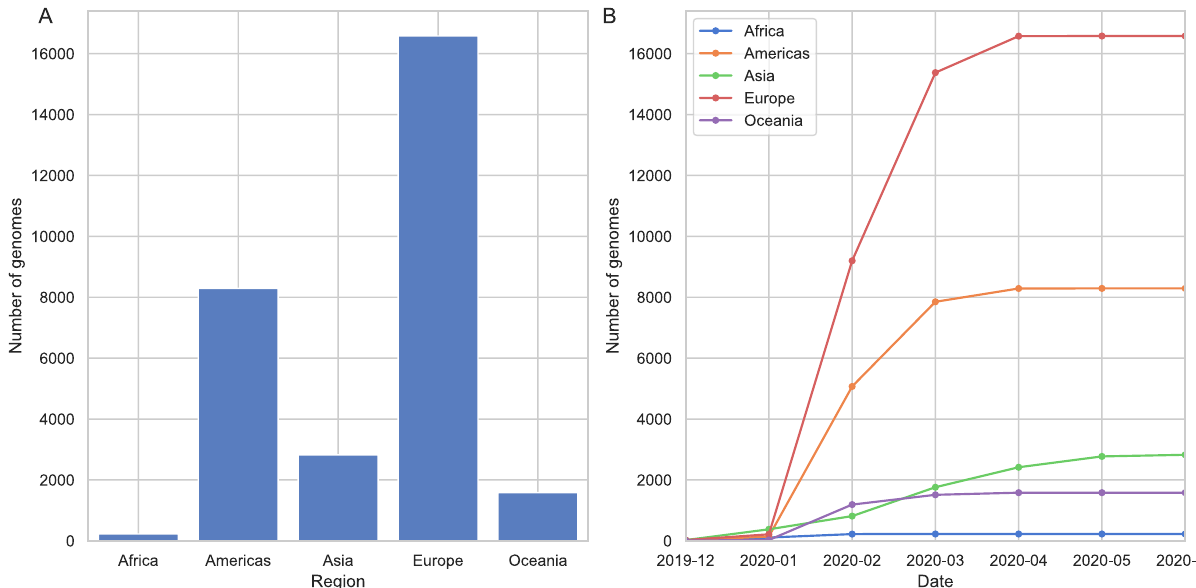
Figure 1. Distribution of SARS-CoV-2 genomes across five continents: ( A ) total number of genomes is shown on y-axis and the regions in x-axis, ( B ) the change in number of genomes collected over the course of pandemic, x-axis shows the collection date. See ( B ) for colors of each